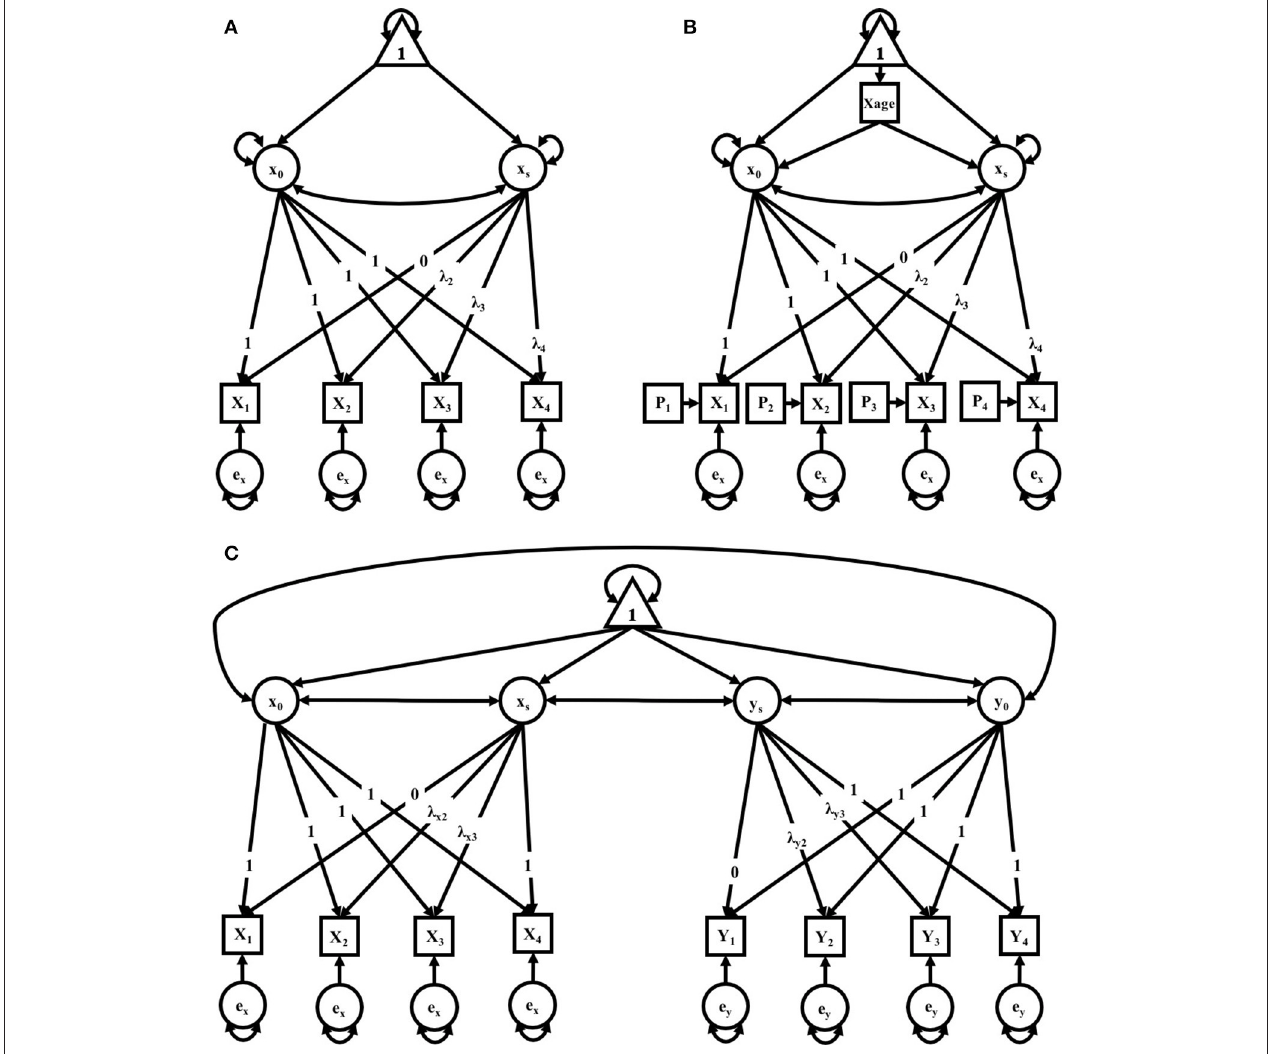
FIGURE 1 | (A–C) path diagrams for Clusters 1–3. Path diagrams are visual representations of model parameters and their relationships, in which each type of model parameter is provided a graphical symbol, i.e., squares or rectangles are used for observed variables (i.e., indicators), circles are used for latent variables and error terms, straight arrows for hypothetical causal or direct effects, and curved arrows for covariances ( Kline, 2016). In all path diagrams presented here (A–C) , composite scores of pub-directed behaviors (PDBs) for each litter (1–4) are represented as sequential squares (from left to right) around indicators by X t or Y t , where t = litter. Each represented composite score (e.g., X t or Y t ) has an error term, e x or e y , which represents variance not explained by the composite scores, including variance due to measurement error. Elements of regression, intercept and slope, are represented by x 0 and x s , respectively, and circumscribed to represent their status as latent variables, each with their own covariance and a covariance between the two. Triangles containing the number 1 represent the inclusion of a term for the analysis of means. As the intercept for each model does not change across time, straight arrows from the intercept factor to each time point are labeled with the number 1, indicating a constraint on estimation of the regression between the intercept and each time point. Straight arrows from the slope factor (x s or y s ) are variably constrained, according to the growth pattern in consideration. Thus, for the no growth model, regression paths from the slope factor to indicators at all time points are constrained to 0; for the linear growth model, regression paths from the slope factor to indicators are constrained to 0, .33, .67, and 1 for litters 1, 2, 3, and 4, respectively; and for the non-linear growth model, only the regression path from the slope factor to litter 1 is constrained (to 0) and all others are freely estimated, as represented by the term λ t . Path diagram (A) represents models tested in Cluster 1, the Independent Maternal and Paternal Models, which includes only the common parameters outlined above. Path diagram (B) represents models tested in Cluster 2, the Independent Maternal and Paternal Models with Covariates, which expands upon the model given for Cluster 1 with the addition of a time-invariant covariate for parental age (X age ) and time-varying covariates for litter size (P t ), both given in squares. Path diagram (C) represents models tested in Cluster 3, the Maternal-Paternal Bivariate Model, which expands upon the model given for Cluster 1 by presenting models for change in maternal and paternal care in parallel with double headed arrows representing covariance between the two models, and therefore covarying trajectories of change between mothers and fathers.